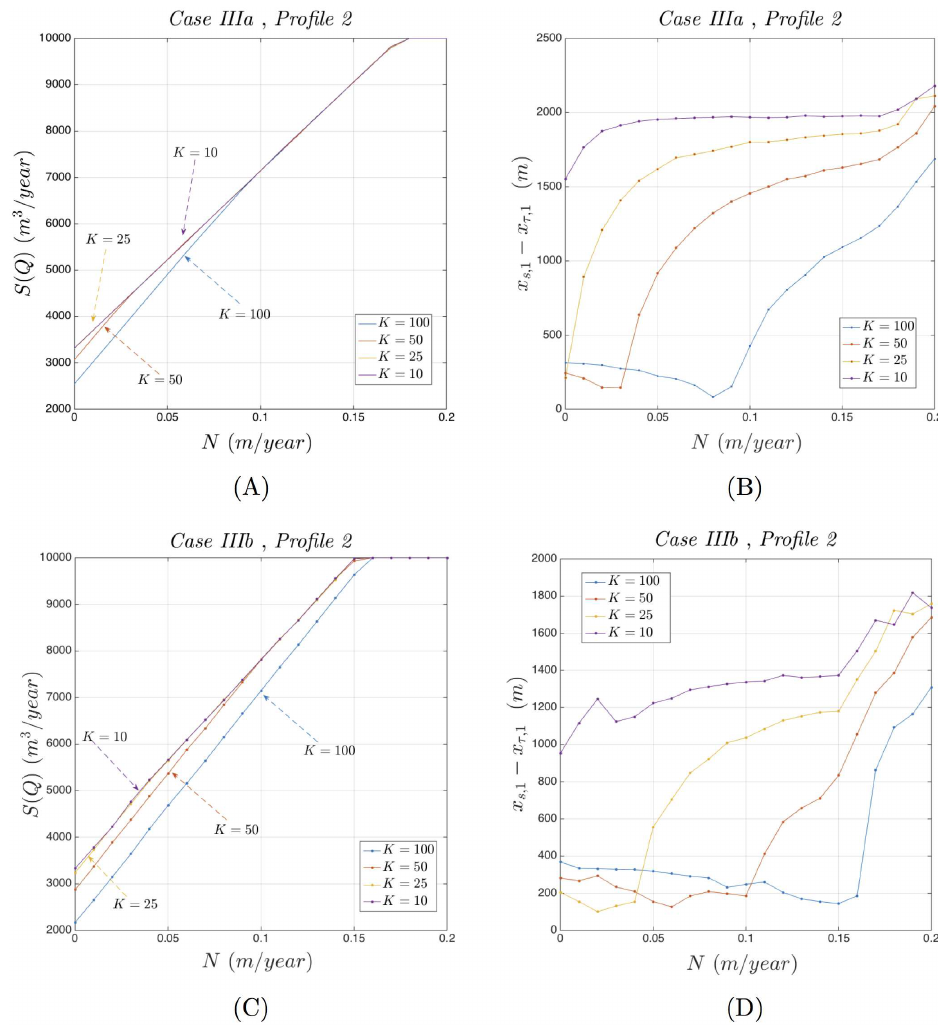
Fig 12. Behavior of S ( Q ) and Δ x s τ under Profile 2. Dependence of S ( Q ) and Δ x s τ on N and K for Test Cases IIIa and IIIb using Profile